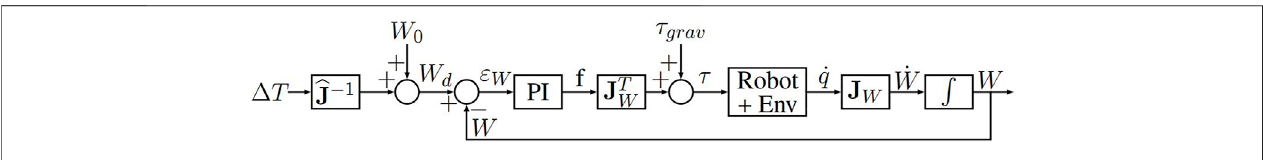
FIGURE 5 | Controller with a well-known mapping between T and W